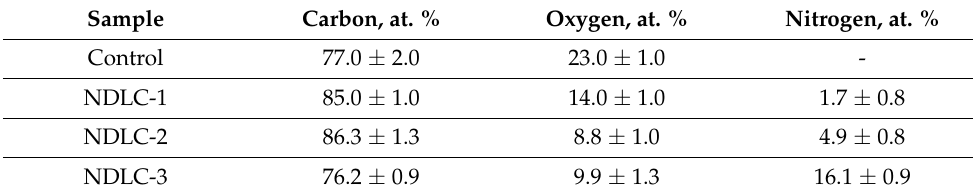
Table 1. Elemental composition of the control and modified scaffolds.